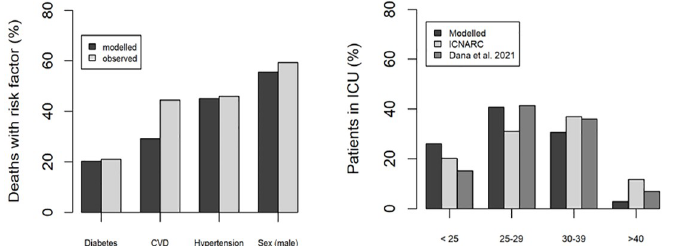
Fig 4. Validation results. Modelled and observed percentage of deaths by risk factor (a) and percentage of patients in ICU by BMI